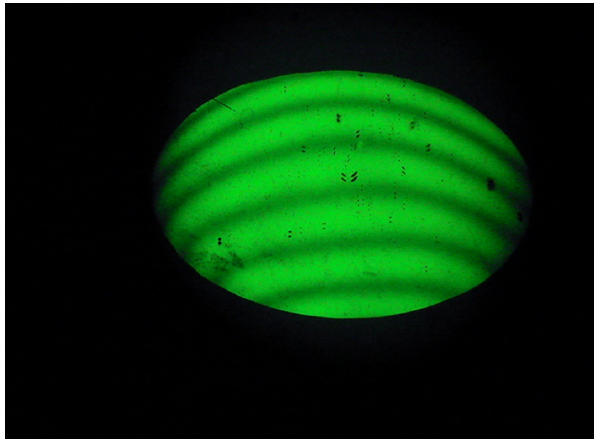
Figure 8. Interferometric test of the steel mirror’s optical flatness at λ = 460nm.